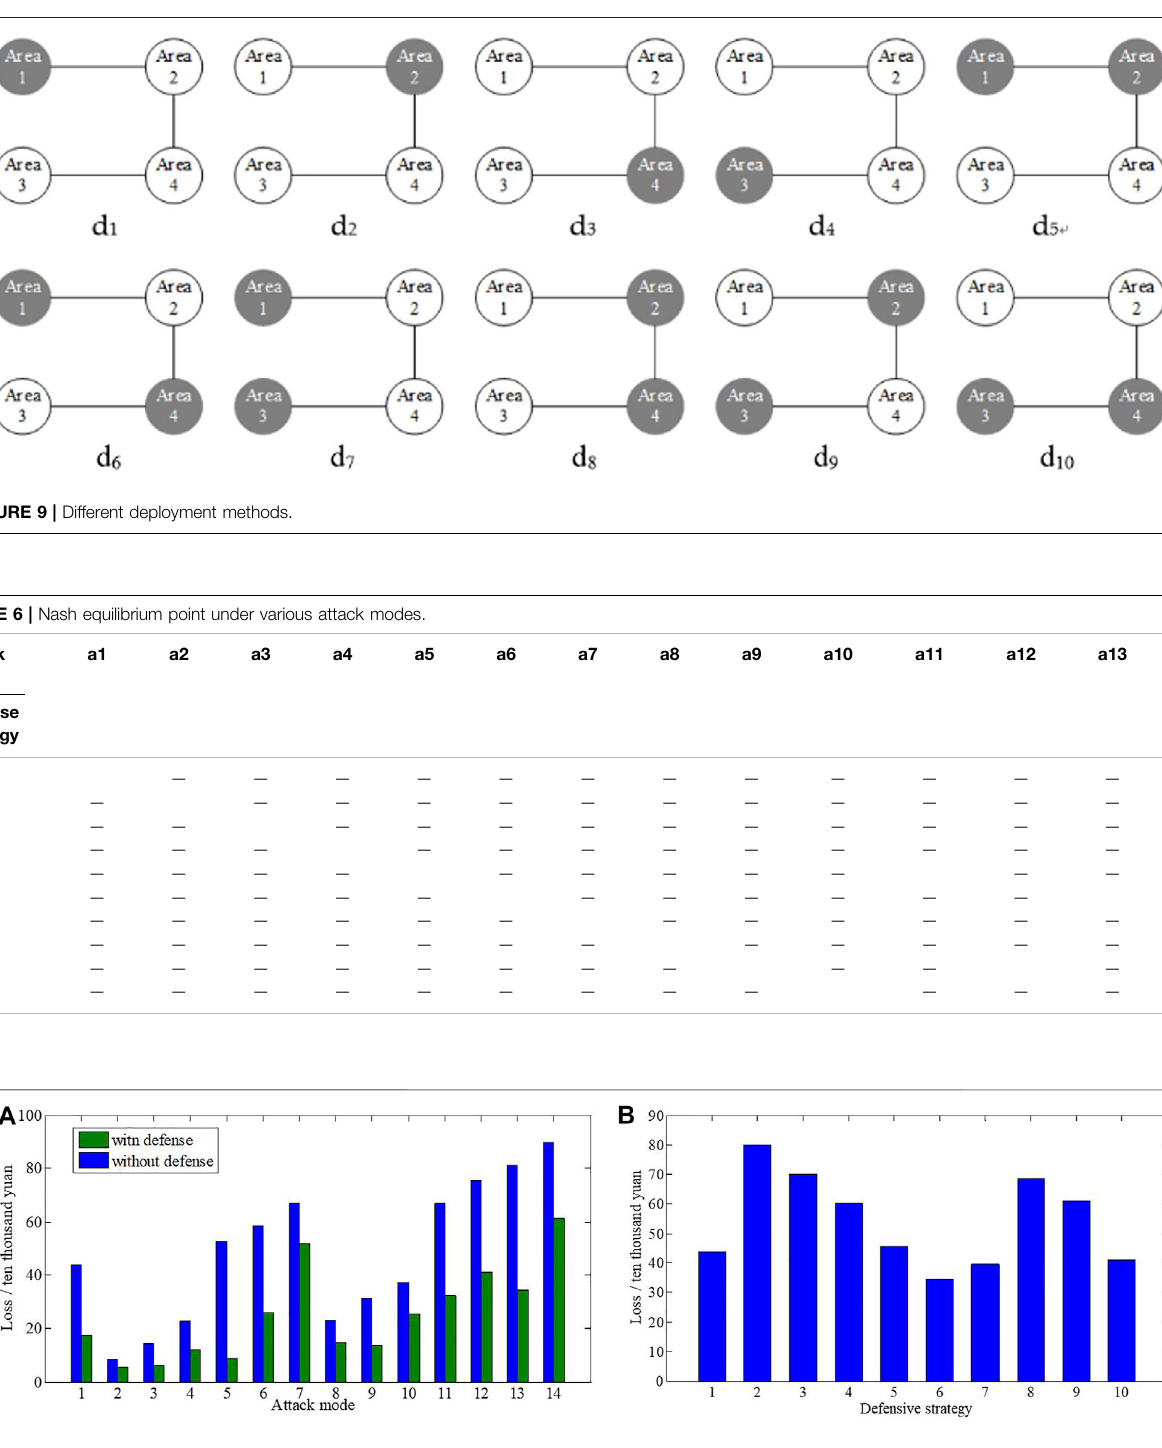
FIGURE 10 | (A) Comparison of losses before and after the game defense. (B) Loss value of different defense strategies under attack mode a13.